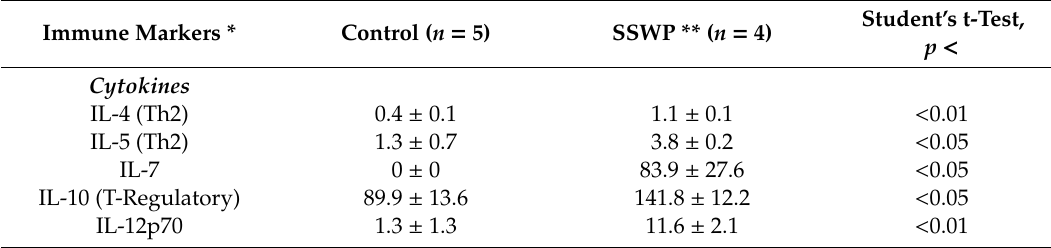
Table 1. Identification of in vivo immune markers for intrinsic wheat protein allergenicity in an adjuvant-free mouse